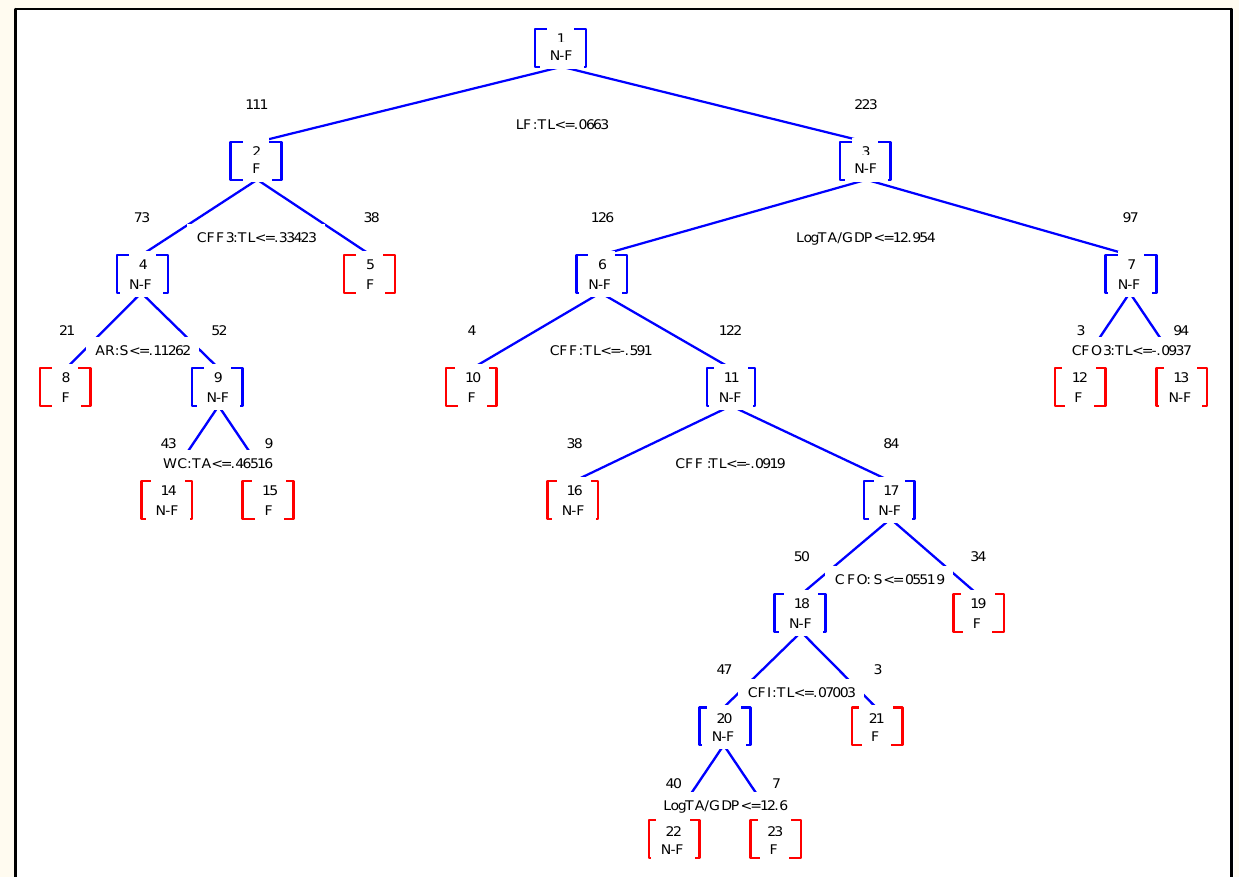
Figure 3: Growth model classification tree Table 11: Classification tree structure for growth model Table 12: Test sample misclassification matrix